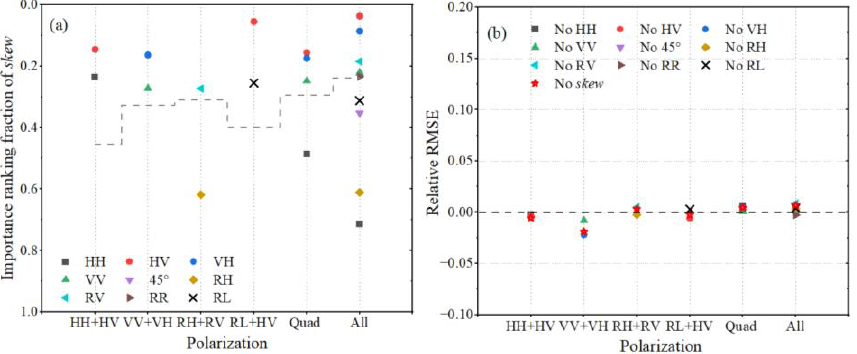
Figure 18. The importance of skew to SWH retrieval from combined-polarization models. ( a ) The importance ranking of skew provided by XGBoost models, normalized to the range of 0–1. ( b ) The effect of removing skew on the SWH estimation from different polarized models. The red penta- grams represent the relative RMSE corresponding to the removal of skew -terms in the combined- polarization models.